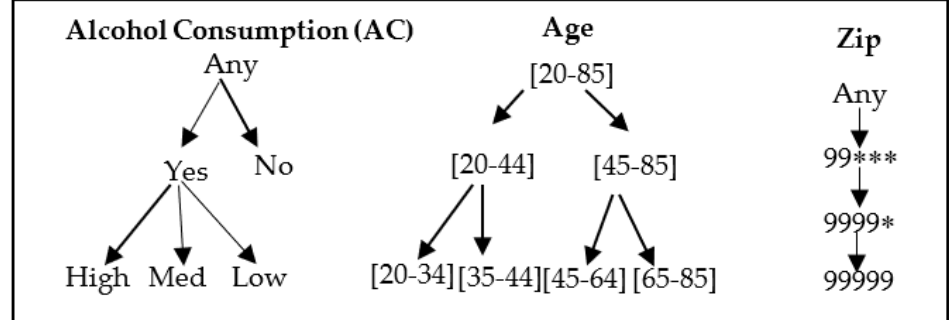
Figure 2. Taxonomy Trees of three attributes in Table 1.